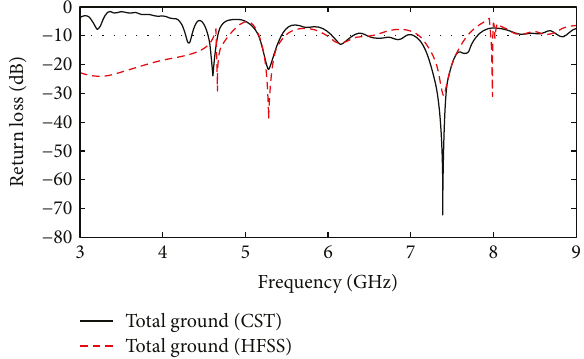
Figure 7: Return loss comparison between HFSS and CST for the array antennas with total ground